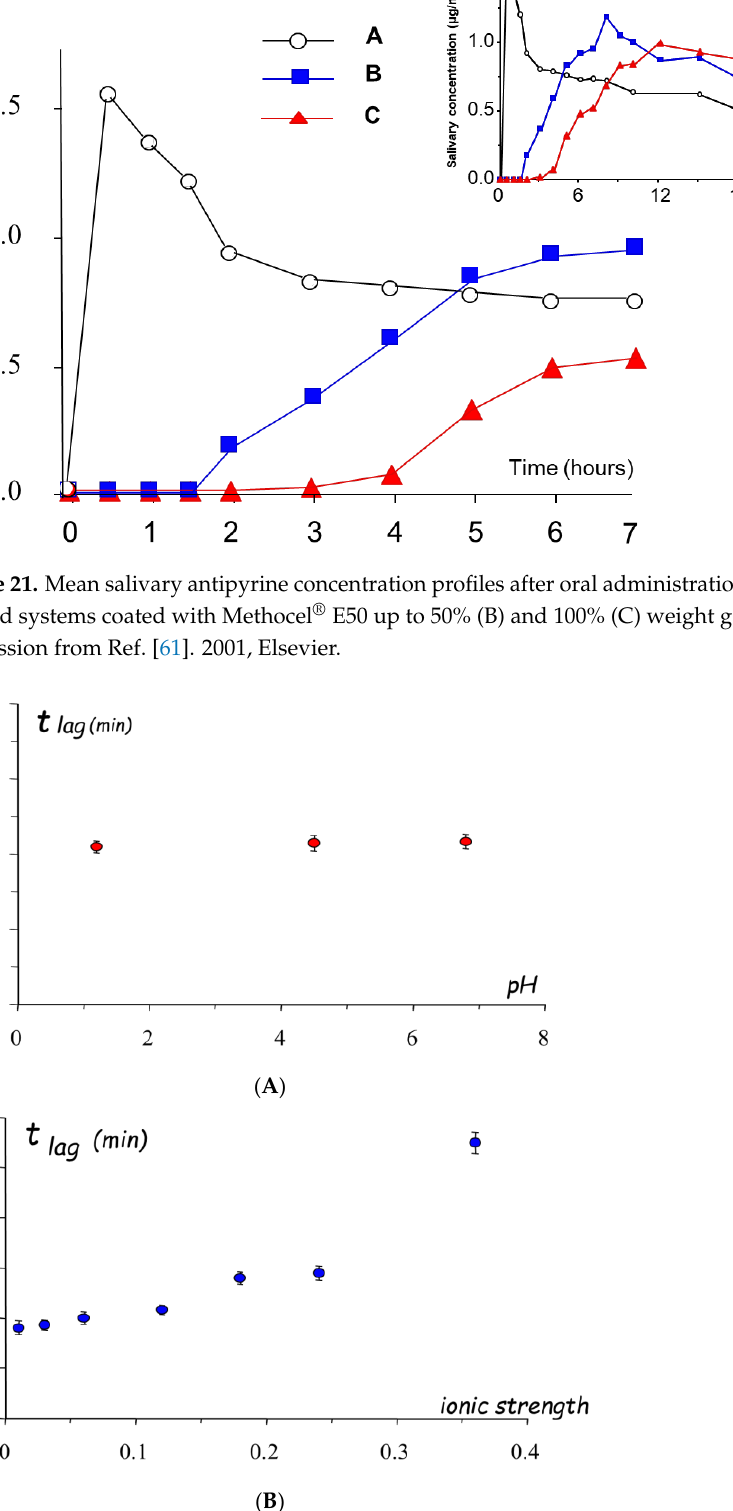
Figure 22. In vitro lag times in media having different pH ( A ) and ionic strength ( B ) of systems coated with Methocel ® E50 to 20% weight gain. Adapted with permission from Ref. [60]. 2004, Elsevier.